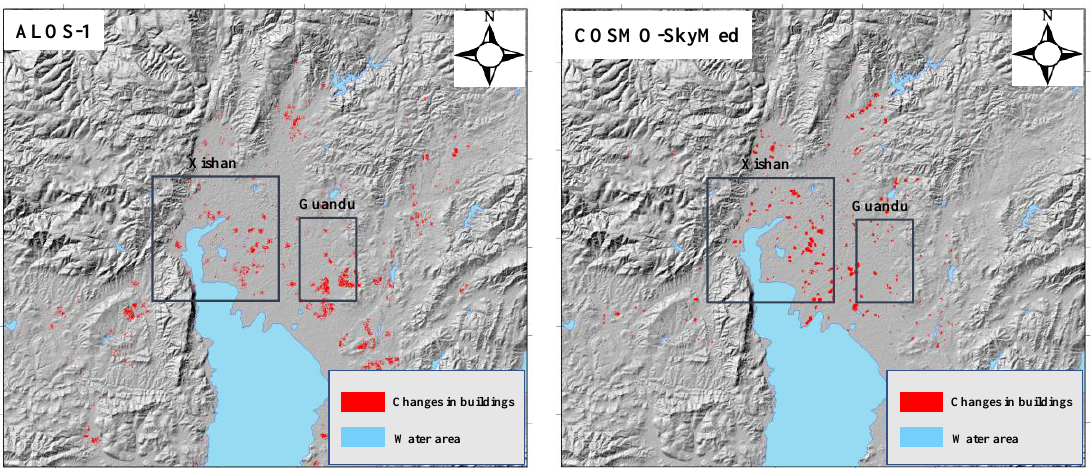
Figure 6. Changes in buildings from ALOS-1 (left) and COSMO-SkyMed (right) in this study.